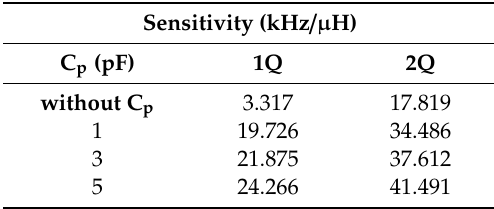
Figure 4. Inductance-to-frequency characteristics of the converter for inductance L L settings in steps from 48.004 µ H to 100.002 µ H (without capacitance C p – the dotted lines and for the di ff erent values of capacitance C p , and for the single- and dual-quartz units at T = 25 ◦ C). The Inductance L L values are set in steps of 48.004 μ H, 65.001 μ H, 75.005 μ H, 80.003 μ H, 85.002